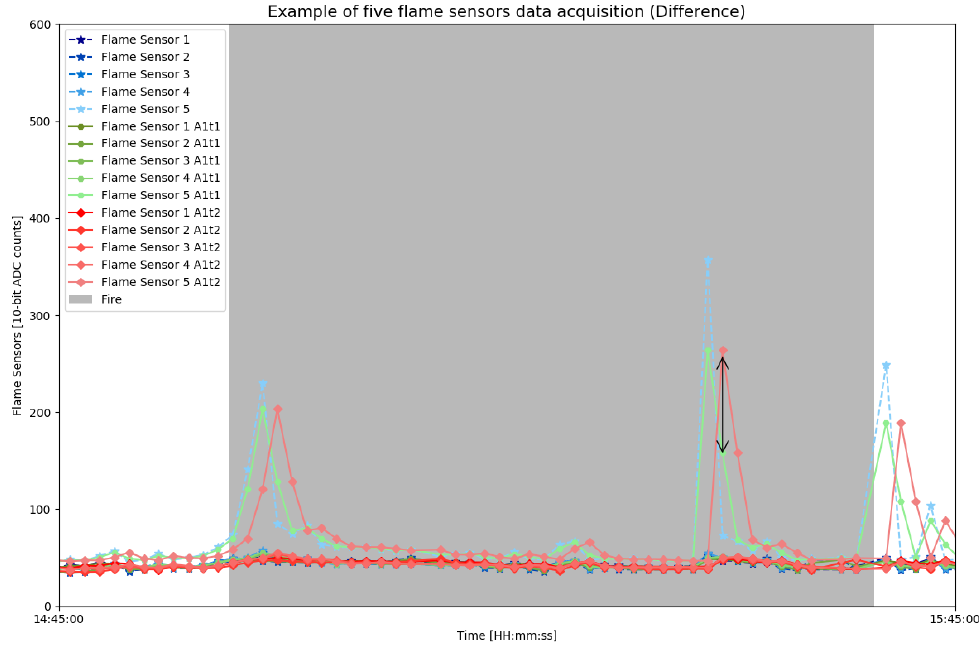
Figure 7. Difference plotting produced by the A 1 approach configured for t = 1 and t = 2. It is possible to graphically visualize the difference between raw and smoothed data at two time